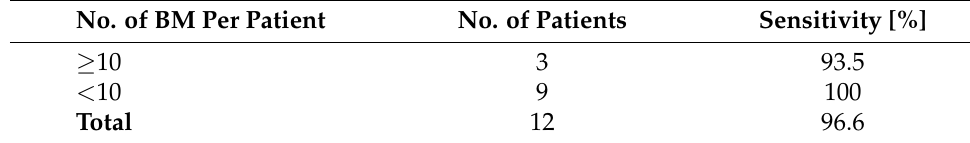
Table 2. Deep Learning Performance in Test-Set Patients according to Metastases.